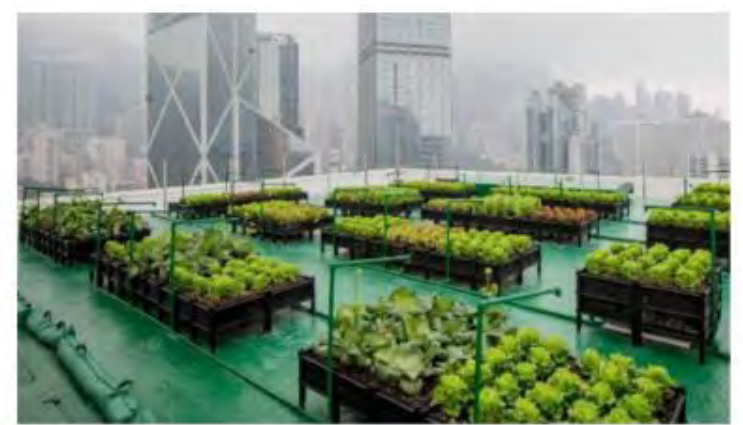
Figure 10. Rooftop urban farming (”Urbanizehub”, n.d.).